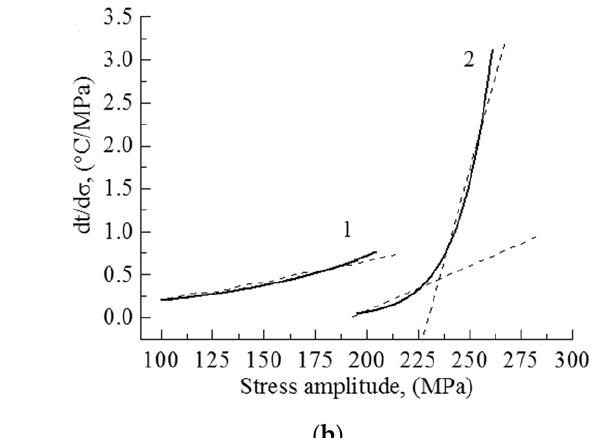
Figure 9. Thermal field images in the infrared zone, during the cyclic loading of UFG Ti-45Nb sample: τ (s)—time, N—number of loading cycles, t—maximal temperature on the surface.